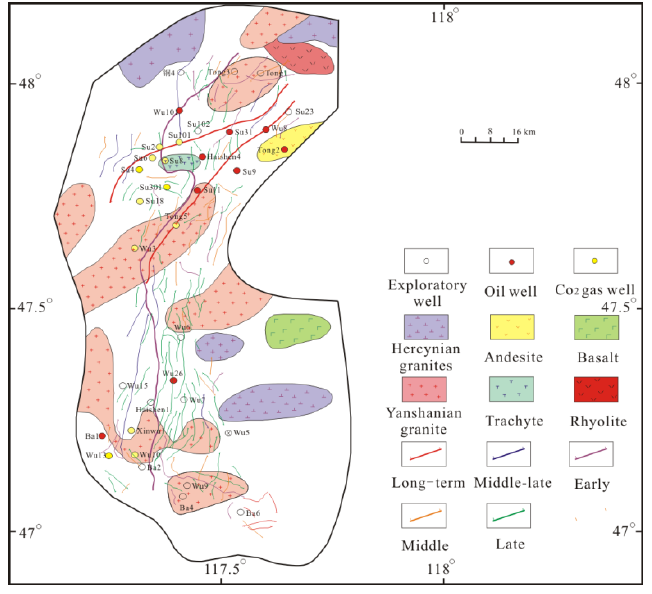
Figure 5. Distribution map of CO 2 gas reservoir and rocks of Wuerxun depression in Hailar Basin (according to Liu Qun, 2007, modified).